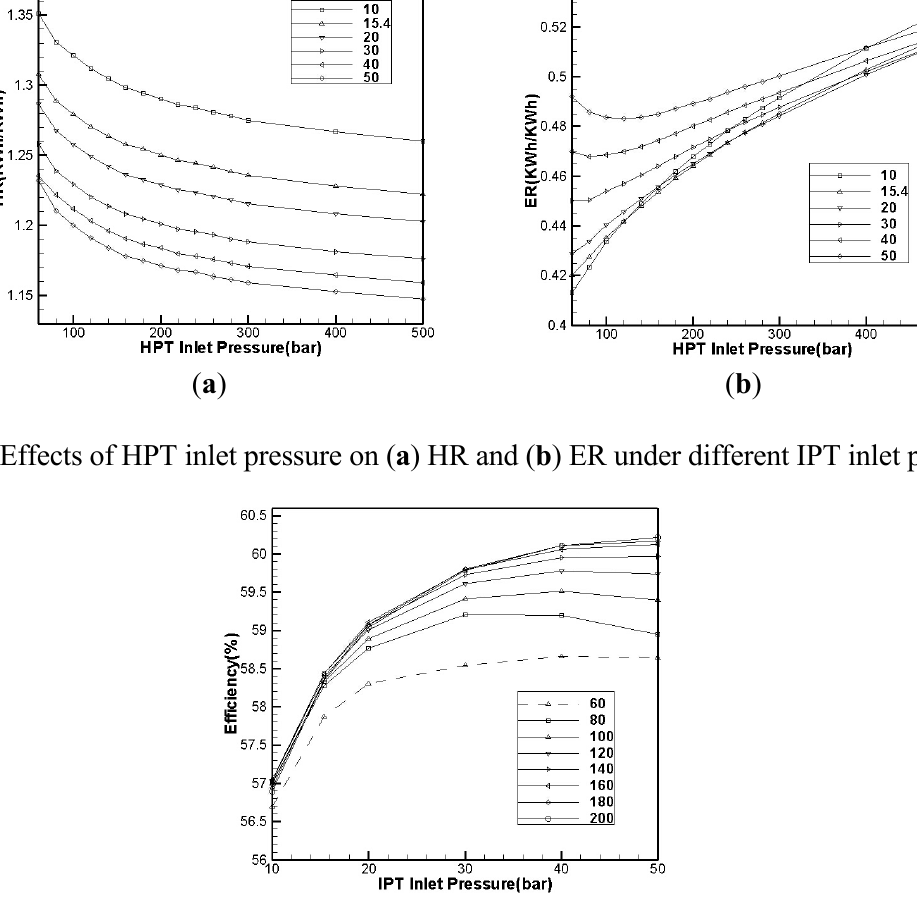
Figure 11. Effect of IPT inlet pressure on efficiency given different HPT inlet pressures.